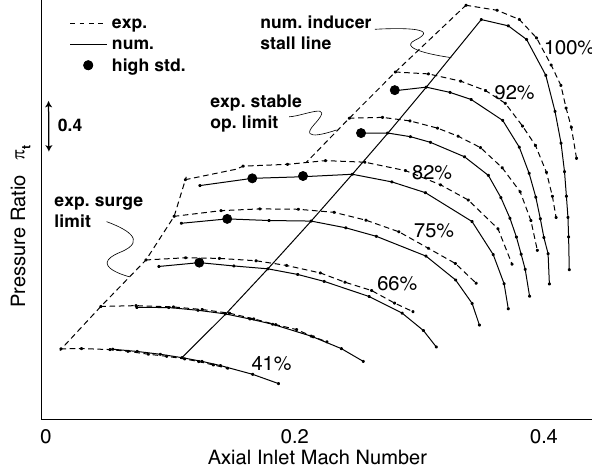
Figure 8. Compressor limits of C1, i.e., numerical inducer stall initiation, experimental surge and stable operation